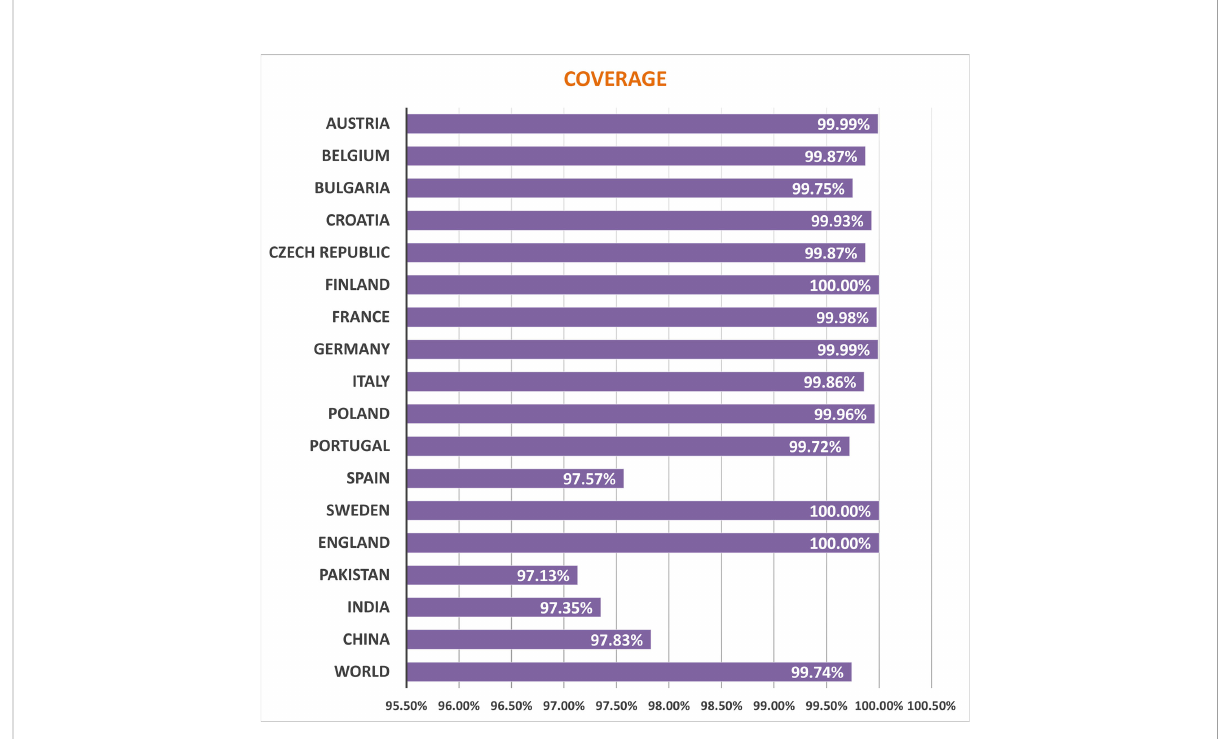
FIGURE 2 Population outreach of screened